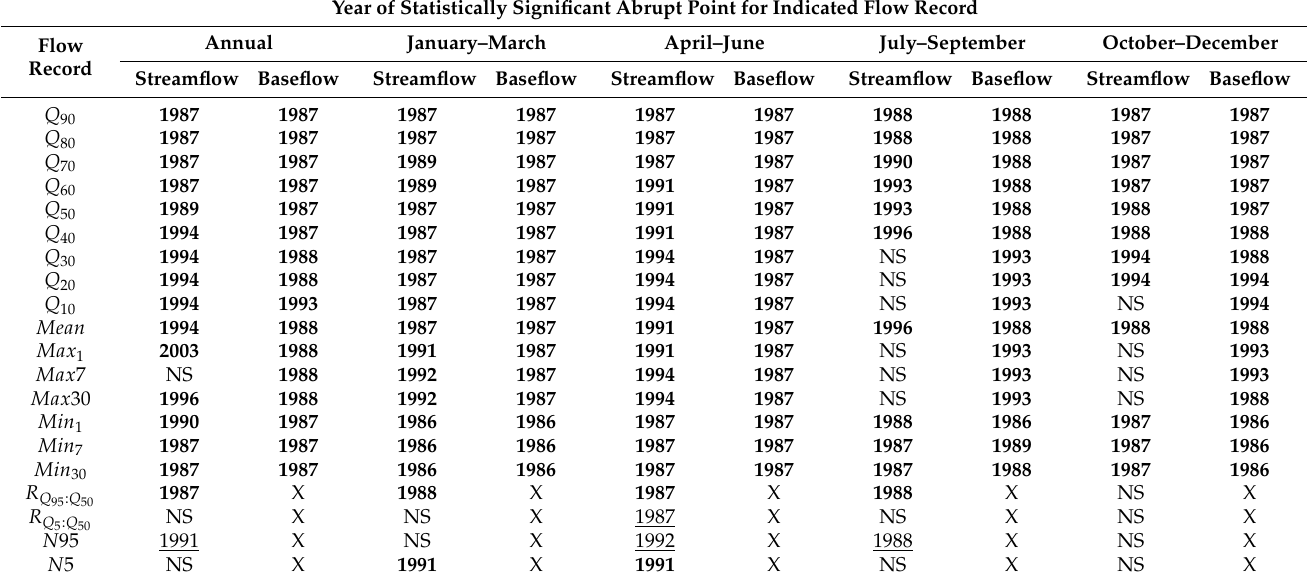
Table 2. Abrupt points detected in flow records of streamflow and baseflow.